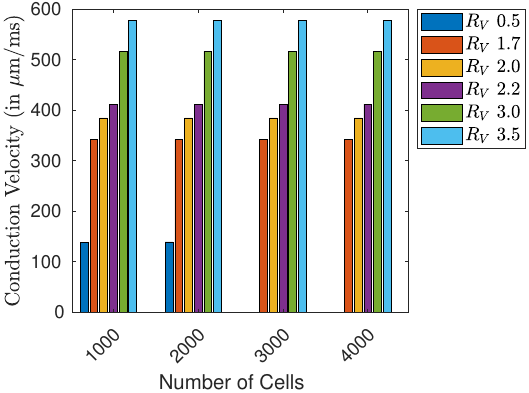
Figure 6. CV (in µ m / ms ) in different sized cell rings with varying value for R V